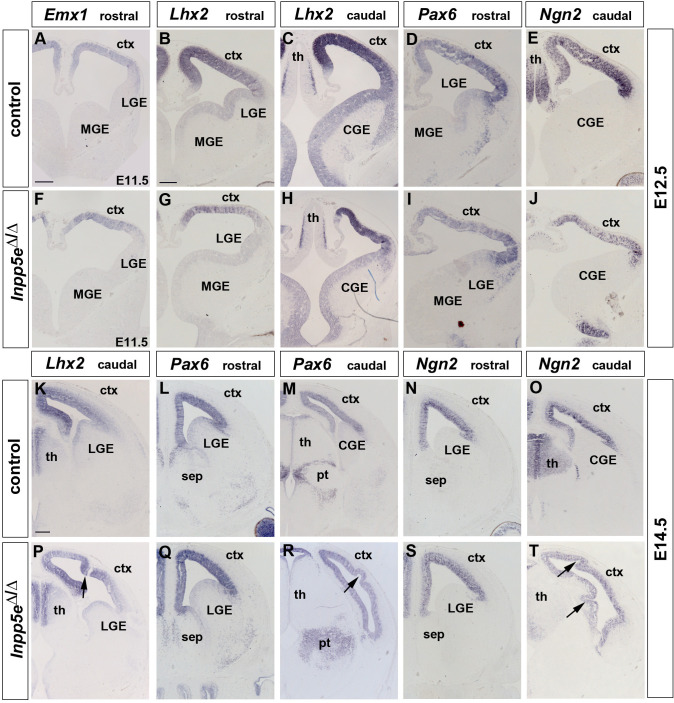
Expression of cortical progenitor markers in Inpp5eΔ/Δ embryos.(A–J) Dorsal marker gene expression at patterning stages (E12.5). Emx1, Lhx2, Pax6 and Ngn2 are still expressed in the developing neocortex of Inpp5eΔ/Δ embryos though the Lhx2 medial to lateral (B, C, G, H) and the Pax6/Ngn2 lateral to medial (D, E, I, J) expression gradients are flatter. (K–T) Neocortical progenitors express Lhx2, Pax6 and Ngn2 in E14.5 Inpp5eΔ/Δ embryos. Note the folding of the neocortex at caudal levels which occurs with 100% penetrance (arrows in P, R and T). CGE: caudal ganglionic eminence; ctx: cortex; MGE: medial ganglionic eminence; LGE: lateral ganglionic eminence; pt: prethalamus; sep: septum; th: thalamus. Scale bars: 200 μm.